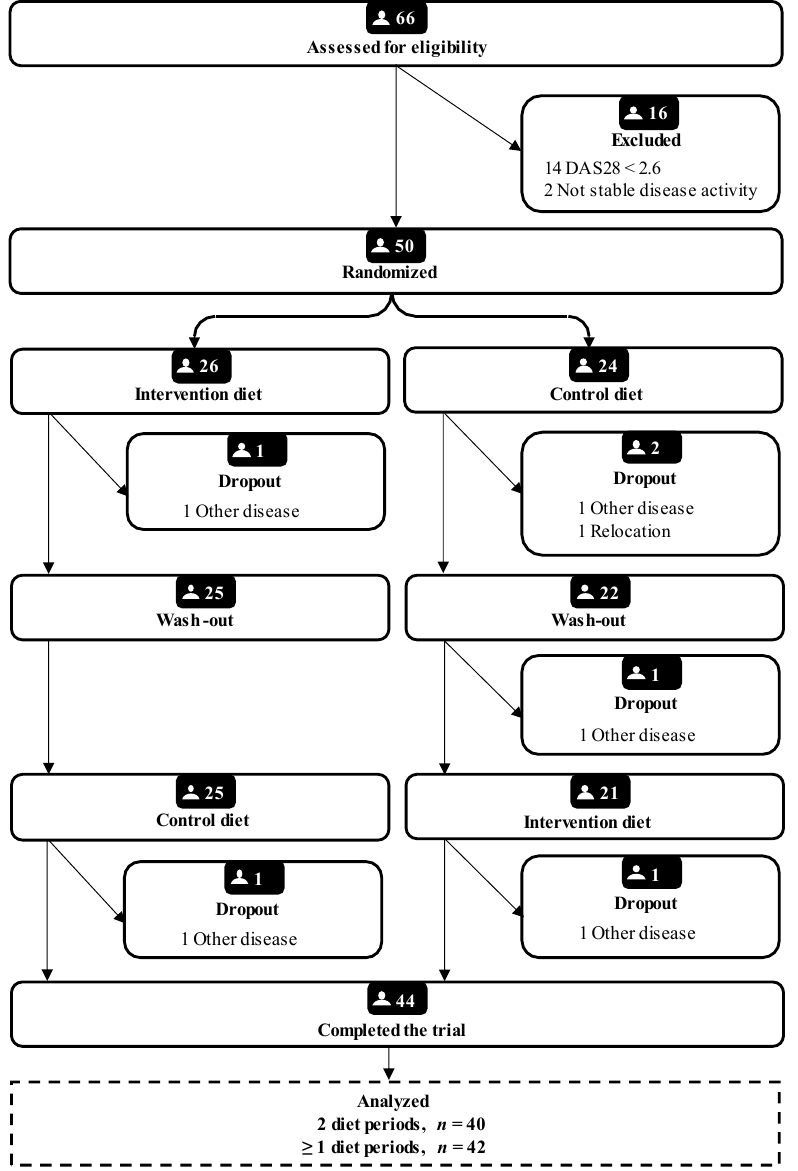
Figure 1. Flow chart of subject recruitment in the ADIRA trial reported according to CONSORT DAS28, Disease Activity Score 28 joints Erythrocyte Sedimentation Rate.